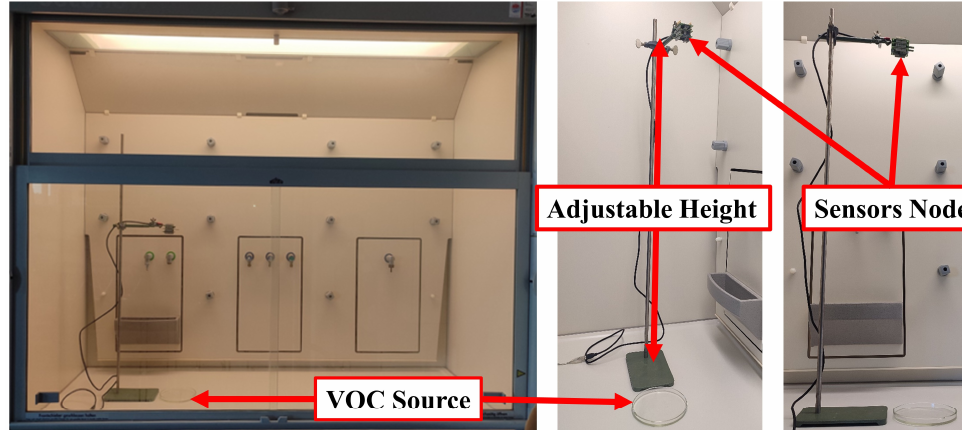
Figure 10. The testing hood with adjustable height stand.